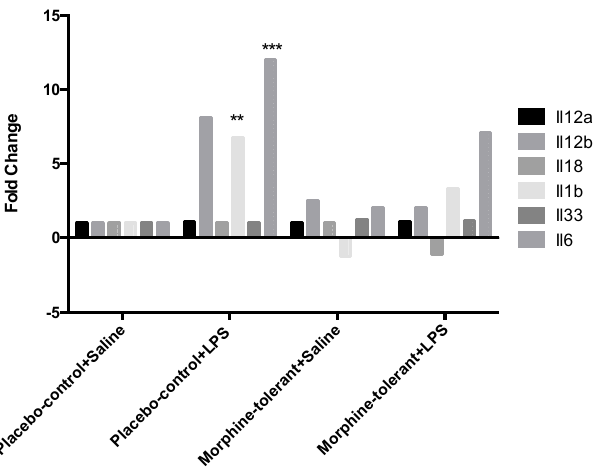
* For p -value, letters in red mean p < 0.05. ** For Fold Change, letters in red mean fold change >2 and letters in blue mean the fold change < − 2. For the color lines, : 6–10 fold decrease; : 2–5 fold decrease;